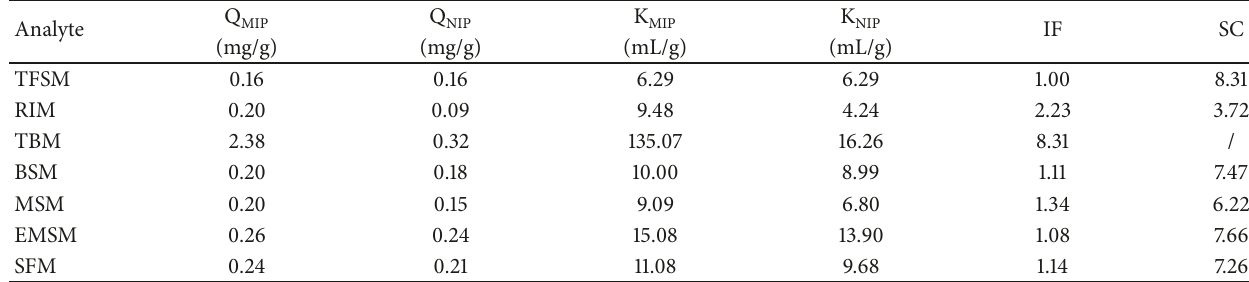
Table 1: Competitive loading of TBM and other analogues by MIL@MIP and MIL@NIP.